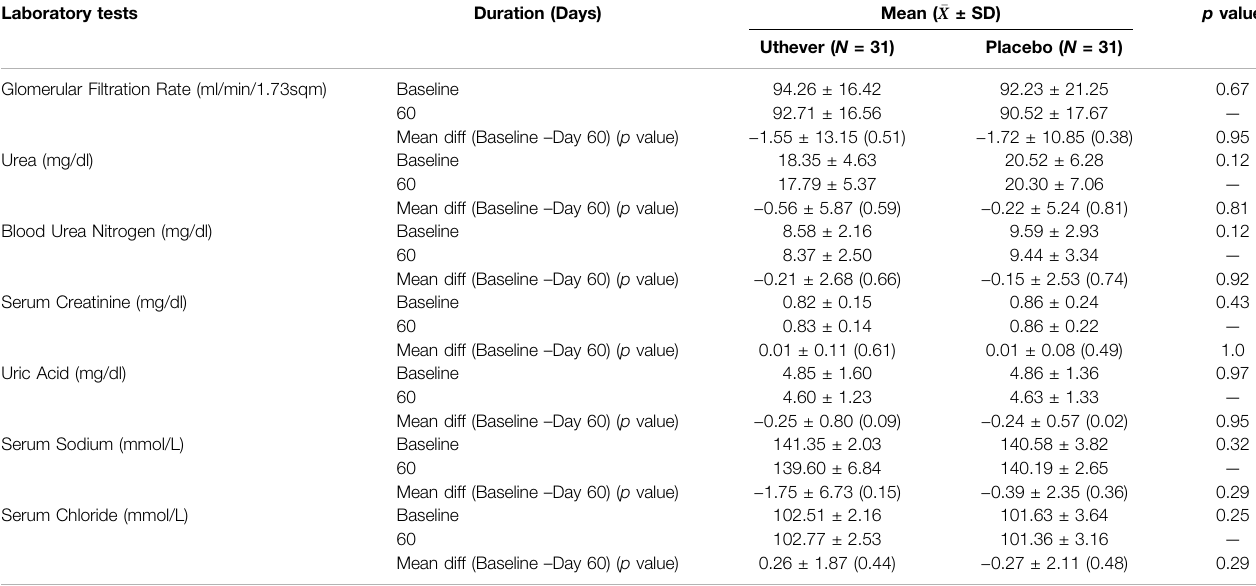
TABLE 12 | Comparison of mean laboratory data (RFT) between groups.